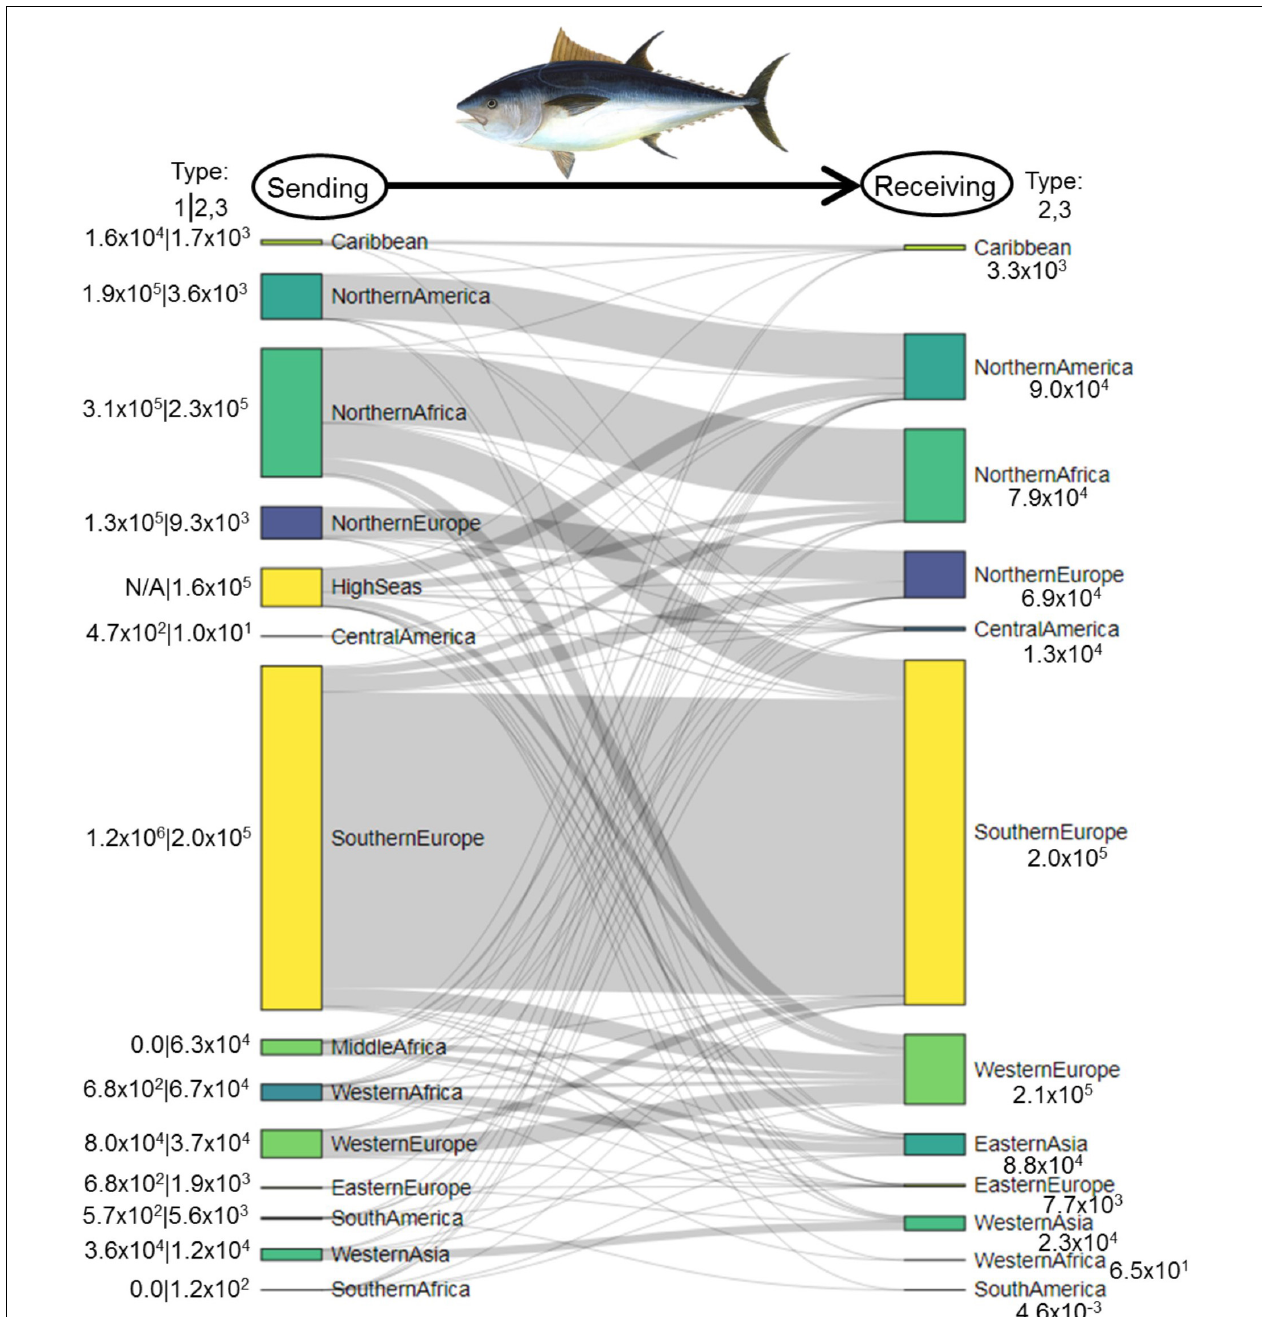
FIGURE 4 | Sankey diagram depicting flows of Atlantic bluefin tuna (metric tons) within and between world regions from sending systems (left) to receiving systems (right) in 1950–2014. In the left margin, numbers to the left of the divider represent Type 1 fishing—total catches by each region within its own exclusive economic zones. Numbers to the right of the divider represent Type 2/3 fishing—total catches in each region by nations located outside the region. Numbers in the right margin are Type 2/3 catches by each region in other regions.